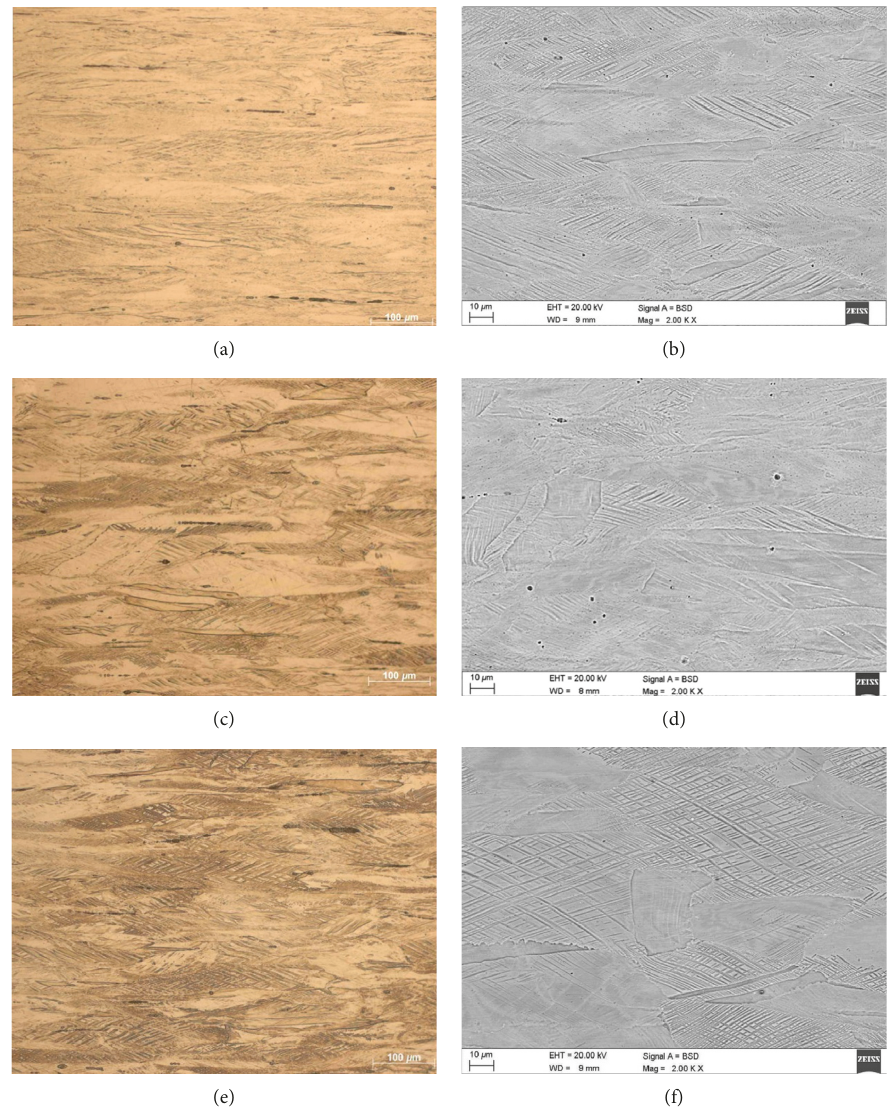
Figure 2: Microstructures of the X6MnSiAlNbTi26-3-3 steel deformed at a temperature of − 40 ° ((a) LM; (b) SEM), 80 ° C ((c) LM; (d) SEM), and 200 ° C ((e) LM; (f) SEM) observed by a light microscope (LM), and a scanning electron microscope Figure 1. Austenite grains are relatively coarse and elongated along rolling direction. Annealing twins were also observed.